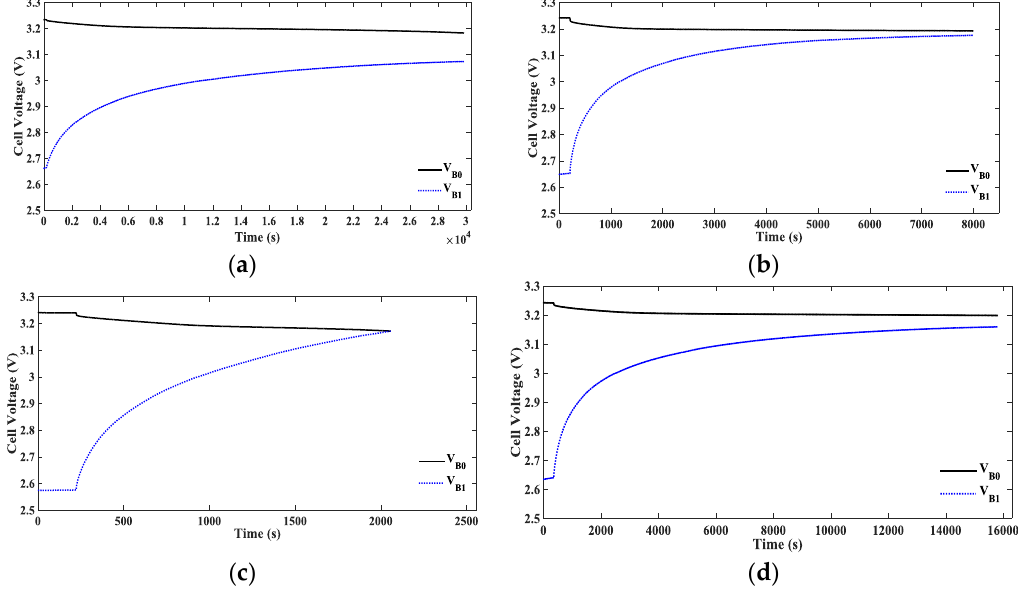
Figure 16. Measured efficiency η e as a function of power at L 0 / C 0 ≈ 10.